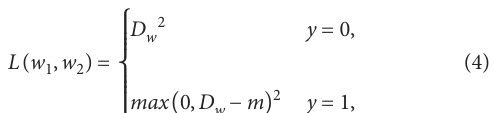
capture the unapparent distortion of the waveform more